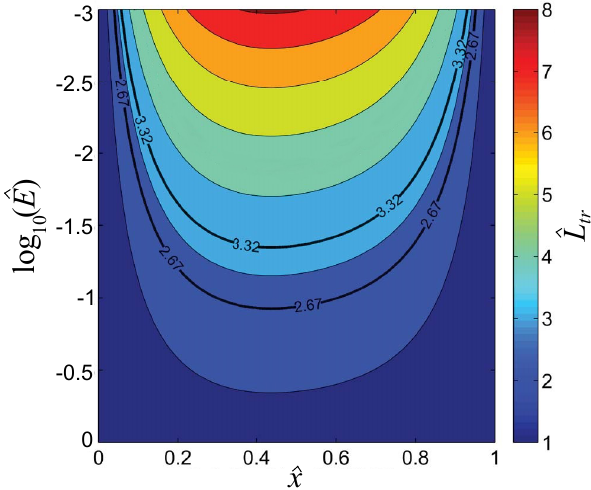
Figure 9. Dependence of L tr on the value of Young’s modulus of the margins ( ˆ E ) and the width of the margin ( ˆ x ) for a discrete margin model all taken relative to the homogeneous elastic model. Colored contours show the relative increase in L tr compared to a homoge- neous linear elastic model ( ˆ E = 1). The two bold contours corre- spond to the conditions necessary to explain the observations of the Rutford fortnightly tidal signal (2.67) and the Rutford semidiurnal tidal signal